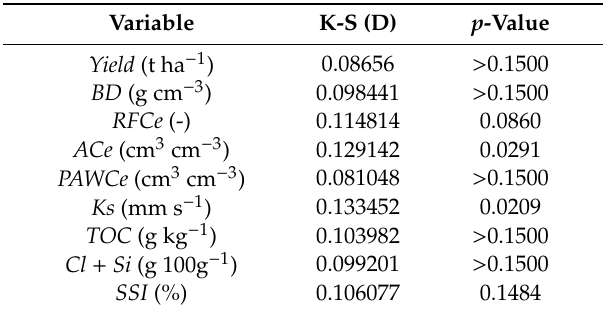
Table 2. Outcomes of the Kolmogorov-Smirnov test